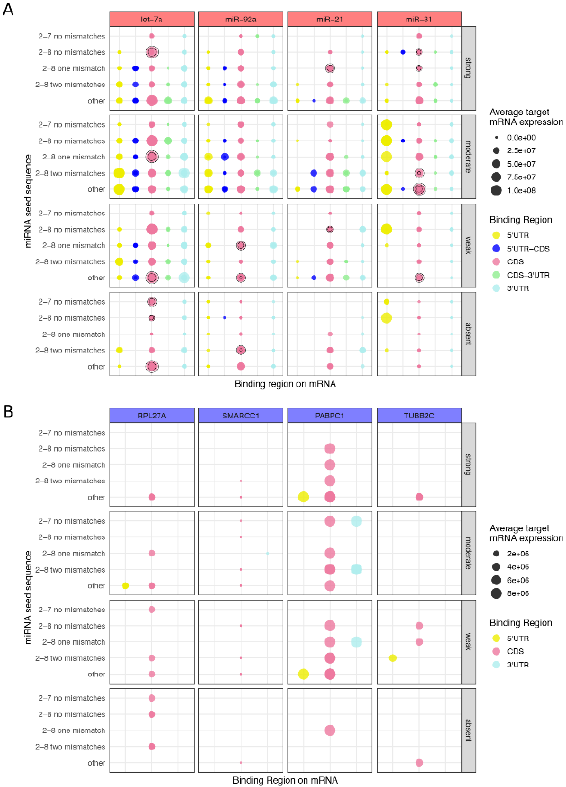
Figure 5. Comparison of miRNA binding characteristics with target mRNA expression levels. ( A ) miRNAs frequently occurring in hybrids and with high expression levels (let-7a, miR-92a, miR-21) or low expression levels (miR-31) in TCGA melanoma patient data (TCGA2015) were selected. The size of the circles corresponds to the average expression of a given target mRNA. For each of the four selected miRNAs, several overlapping dots are displayed (highlighted with black circles), as the miRNA can bind to several different targets. ( B ) Selected mRNAs frequently occurring in hybrids and with high expression levels in melanoma patient data (TCGA2015) (RPL27A, SMARCC1, RAPBC1, and TUBB2C) are shown. The binding characteristics (seed match, supplemental 3 ′ pairing or strength, and binding region on mRNA) are illustrated as well as the average target mRNA expression levels. The size of the circles represents the average mRNA expression, which remains constant, as the expression of the gene is stable. The exact values, expression levels, and binding characteristics are illustrated in Table S3.